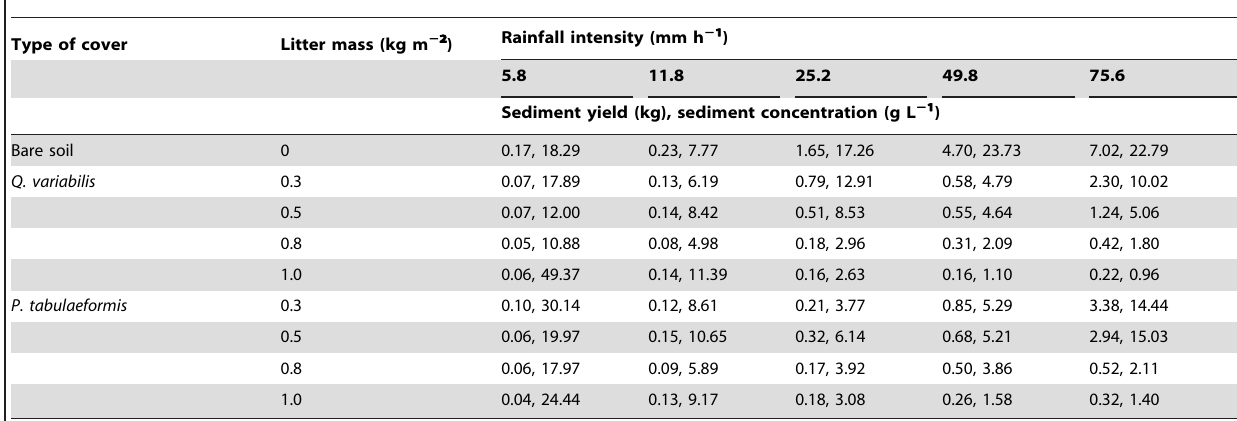
Table 4. Sediment yield and sediment concentration data corresponding to each treatment and simulated rainfall event.